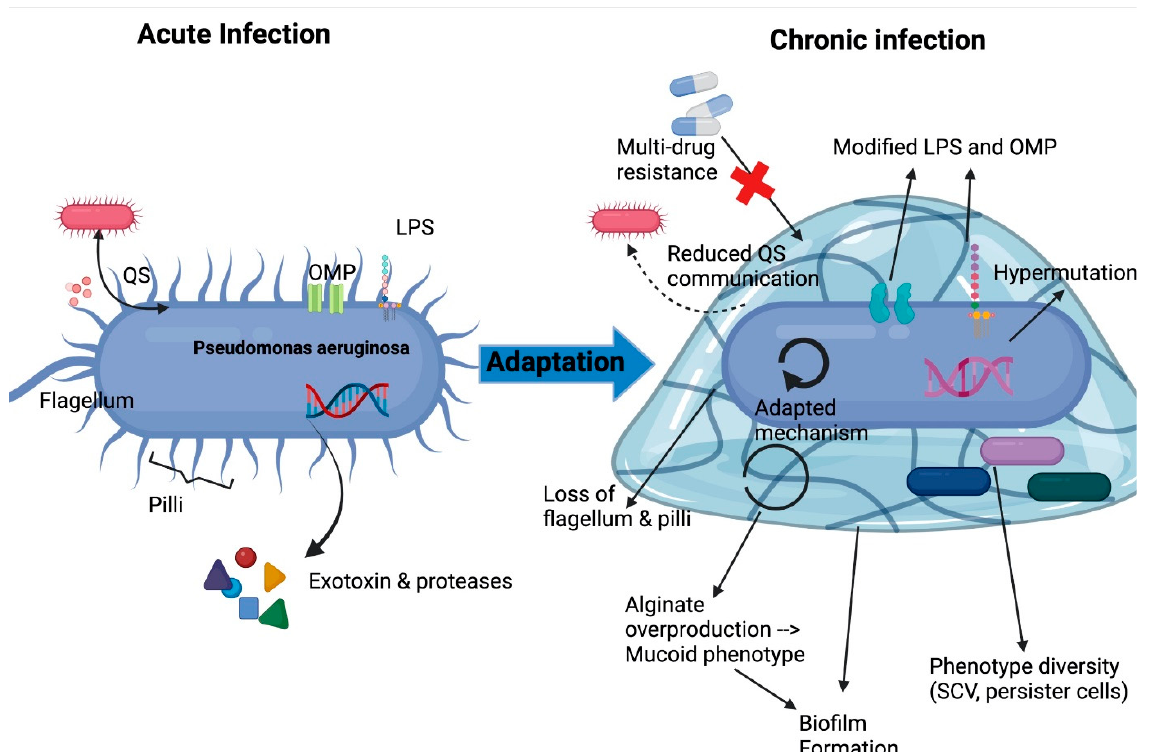
Figure 2. Adaptation mechanisms of P. aeruginosa in lung environment leading to chronic infection. LPS, lipopolysaccharide; OMP, outer membrane protein; QS, quorum sensing; SCV, small colony variants. Adapted from Jurado-Martin et al. [14].